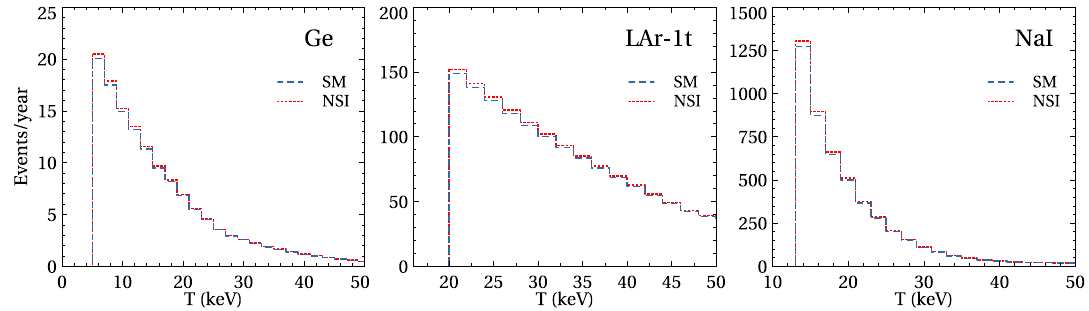
Figure 2 . Expected number of events per year as a function of the nuclear recoil energy for the upcoming Ge, LAr-1t, and NaI detectors as shown in the left, middle, and right panel, respectively. The blue dashed lines correspond to the SM framework, while the red dotted lines represent the NSI scenario with M Z 0 = 0 : 1 GeV and g 0 = 2 (cid:2) 10 (cid:0) 5 , for the type A 2 model. The details about the benchmark values of M Z 0 and g 0 that are considered here are presented in (cid:12)gure